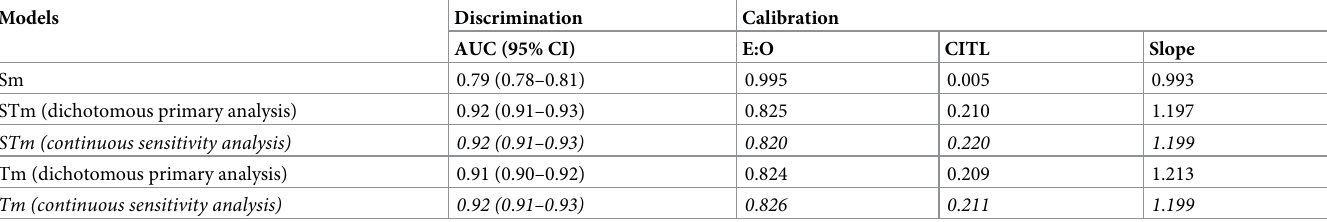
Table 5. Prediction model discrimination and calibration statistics.